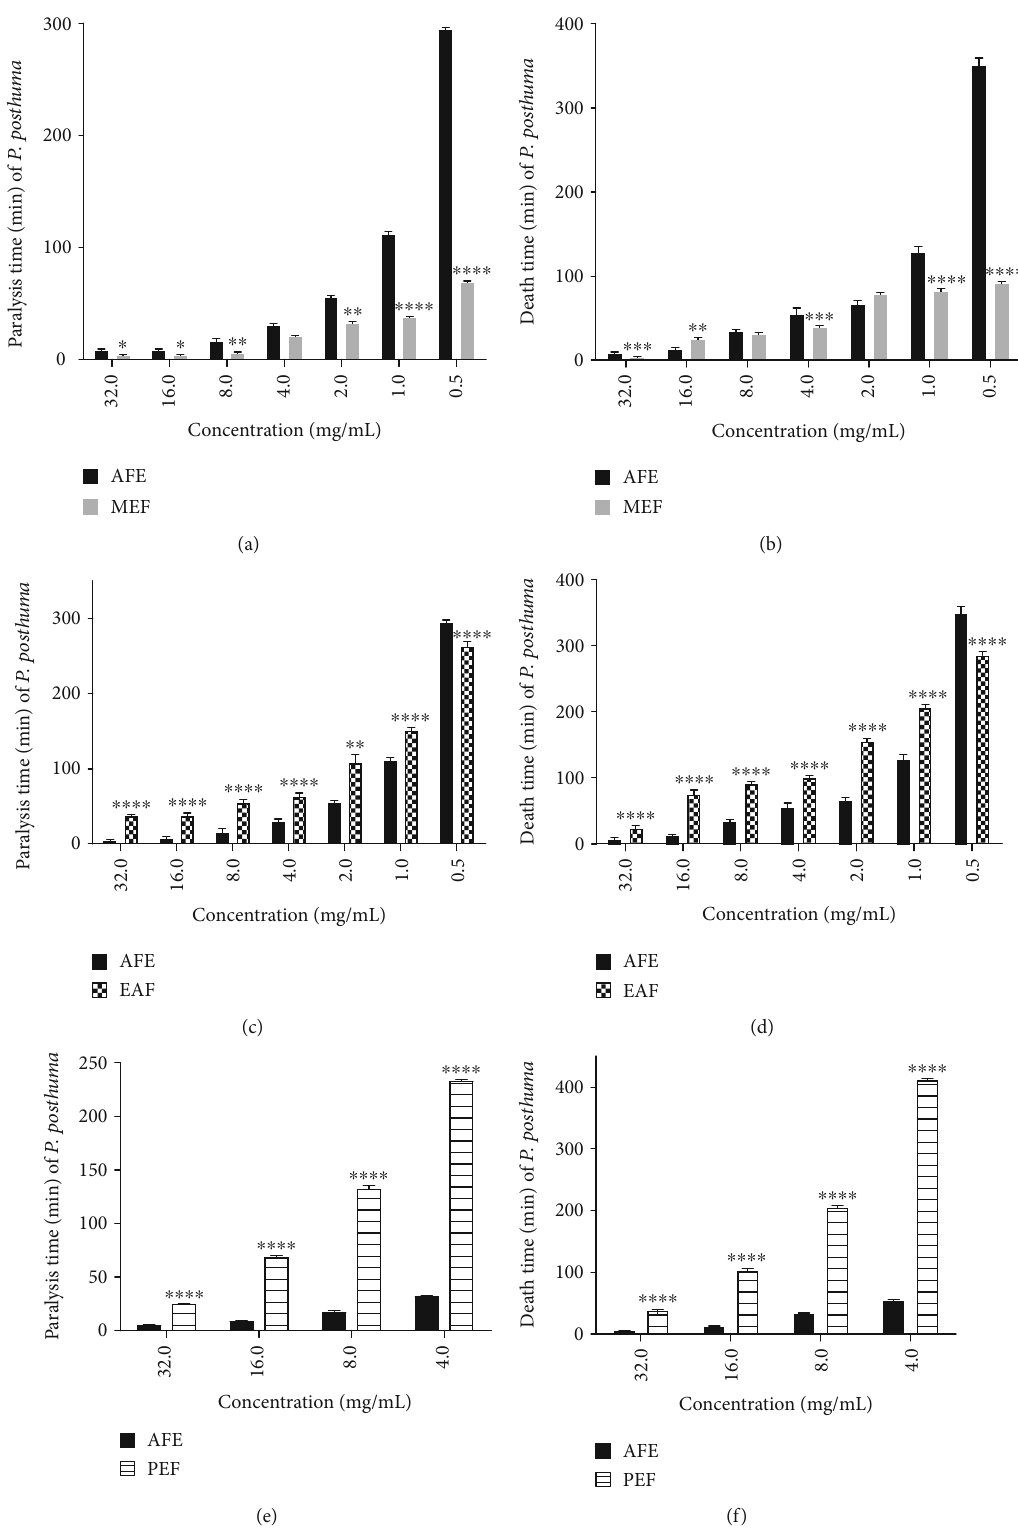
Figure 5: Comparison of the e ff ect of AFE and its fractions (methanol, ethyl acetate, and petroleum ether fractions) on paralysis and death time of P. posthuma. (a, b) Paralysis and death time of methanol fraction, respectively. (c, d) Paralysis and death time of ethyl acetate fraction, respectively. (e, f) Paralysis and death time of petroleum ether fraction, respectively; ∗∗∗∗ p < 0 : 0001 , ∗∗∗ p < 0 : 001 , ∗∗ p < 0 : 01 , and ∗ p < 0 : 05 compared to control (one-way ANOVA followed by Dunnett ’ s post hoc test). AFE: A. ferruginea ethanol stem bark extract; MEF: methanol fraction of AFE; EAF: ethyl acetate fraction of AFE; PEF: petroleum ether fraction of